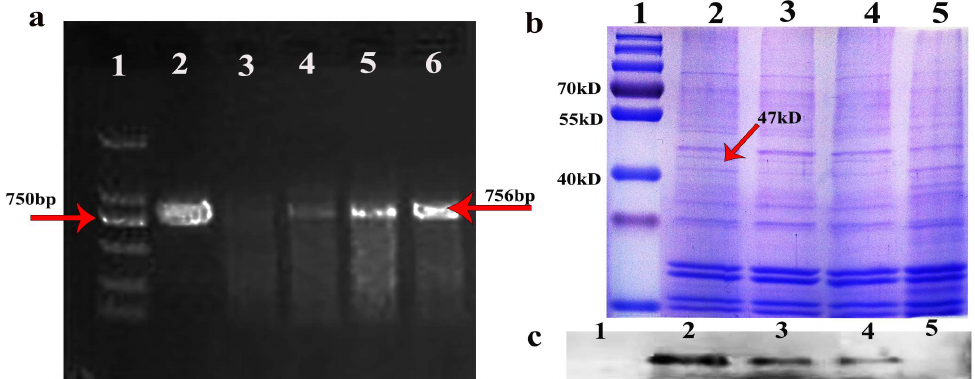
Figure 1. Identification of transgenic Arabidopsis . ( a ) PCR-identified using genomic DNA as a template and hFGF5-specific primers. line1: DNA marker, line2: hFGF5 positive control, line3: wild type Arabidopsis genomic as a negative control, line4–6: transgenic Arabidopsis genomic DNA as a template and hFGF5-specific primers (Red arrow (right) indicates the target band of 756 bp). ( b ) SDS-PAGE of the transgenic Arabidopsis (Red arrow indicates the expressed protein of 47 kD). ( c ) Western blotting identified the oleosin-hFGF5 fusion protein. line1: protein mark, line2–4: fusion protein from transgenic Arabidopsis , line5: protein from wild type Arabidopsis .